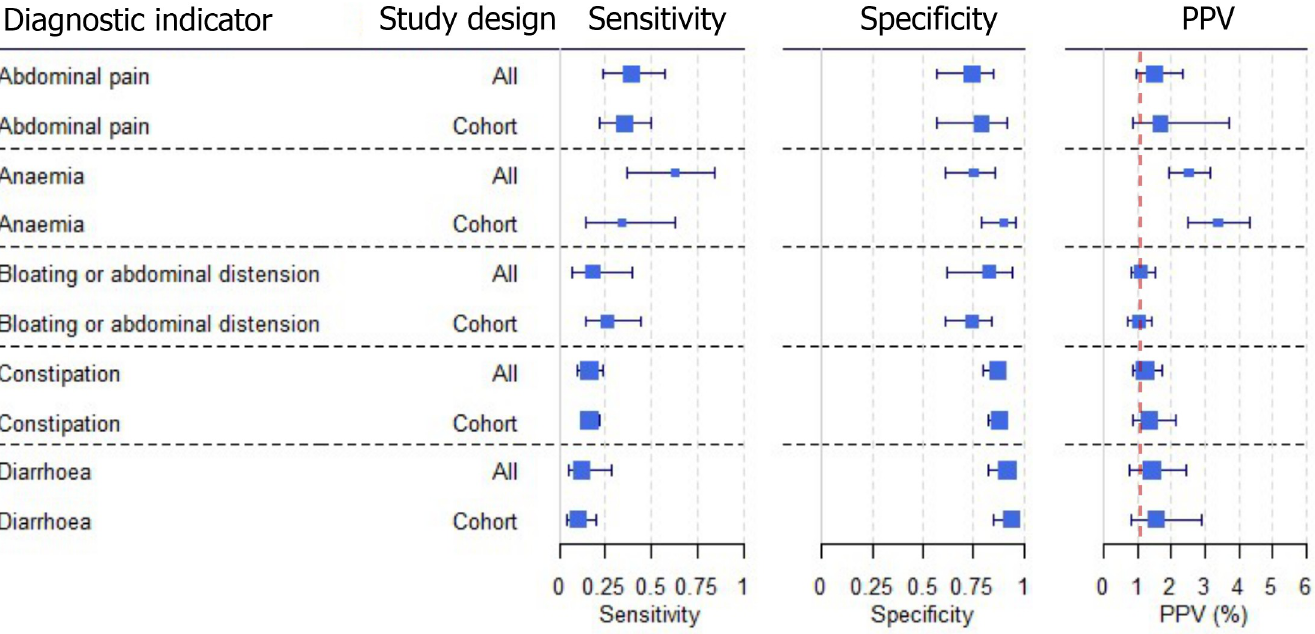
Fig 5. Sensitivity analysis restricting to cohort studies. Sensitivity meta-analysis on study design. Positive predictive values (PPVs) were calculated for a population with a CD prevalence of 1% (red dotted line) using the estimated sensitivities and specificities from the meta-analyses. The area of the box size is proportional to the total number of